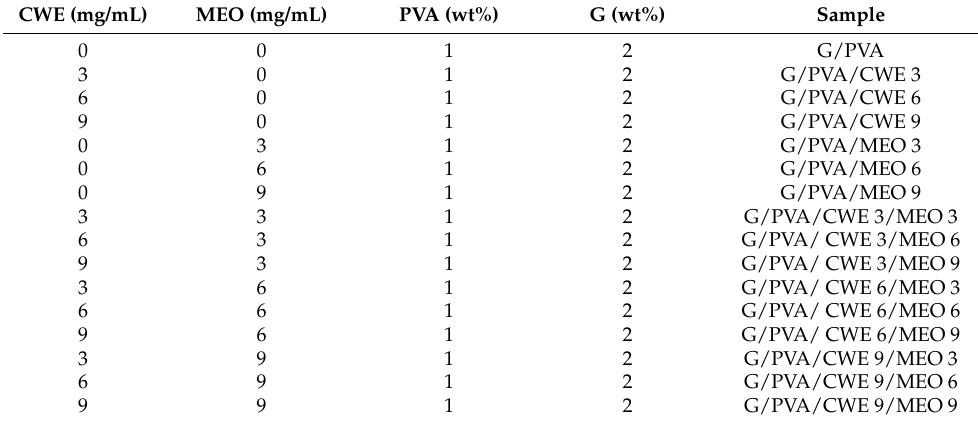
Table 1. Composition of the biodegradable active